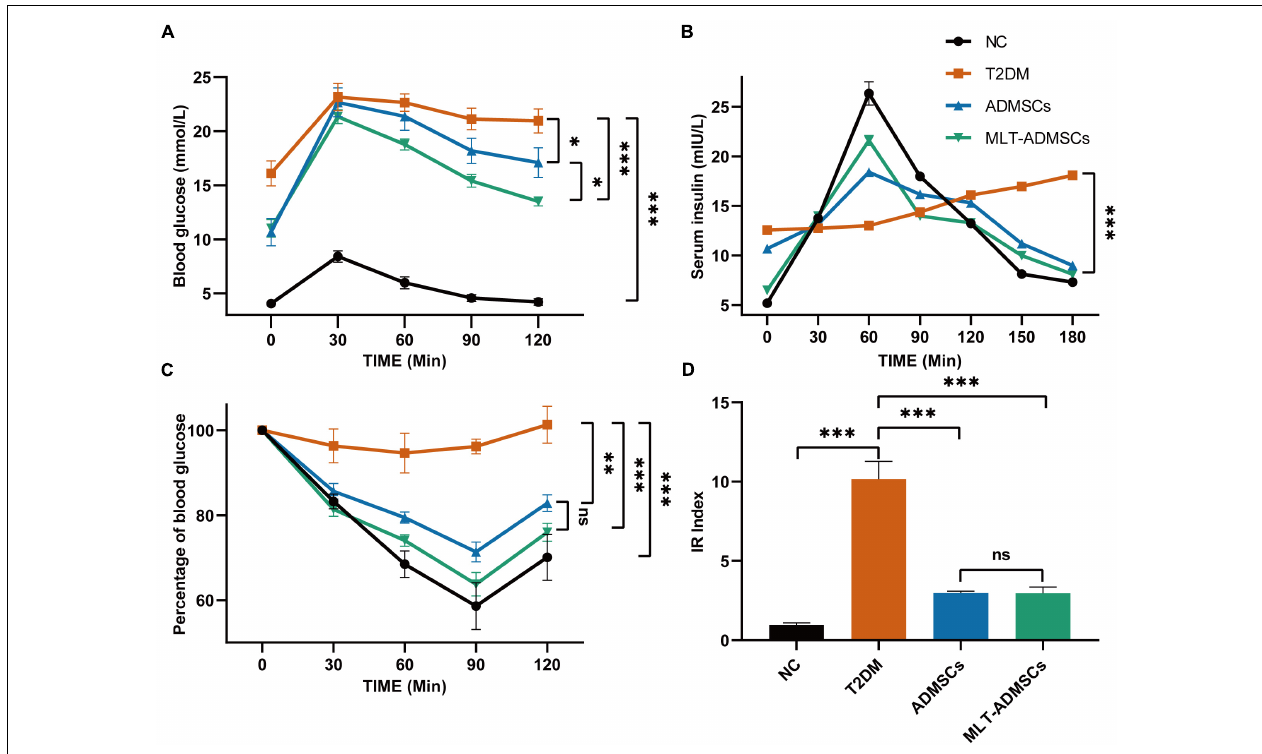
FIGURE 3 | MLT enhances the recovery effect of ADMSCs on insulin resistance in T2DM mice. (A) OTGG. (B) IRTs. (C) IPITT. (D) IR index in each group, HOMA-IR index = [FBG (in mmol/L) × FINS (in units/L)]/22.5. The blood glucose level in each group was detected after fasting for 3 h. Values in this figure are the mean ± SE;